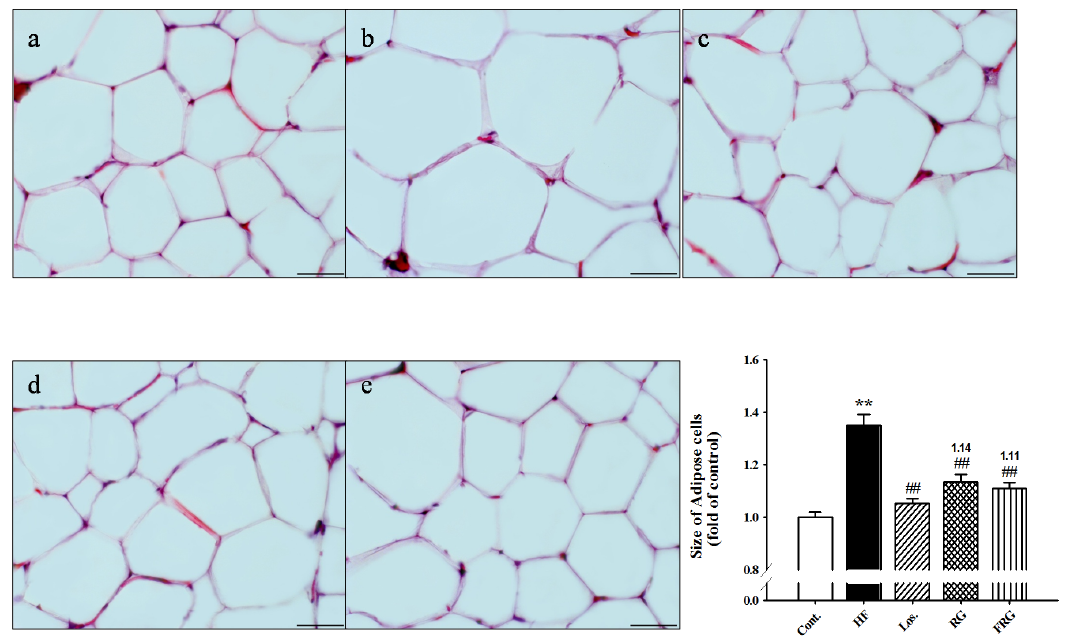
Figure 1. Effects of fermented red ginseng (FRG) on adipocytes on high fructose (HF) diet rats. Representative microscopic photographs of hematoxylin and eosin (H & E) stained sections of epididymal fat pads in HF diet rats. The lower panels indicated the size of adipose cells (magnification ×400). Scale bar shows 50 μ m. ( a ) control; ( b ) HF; ( c ) HF + Losartan (Los.); ( d ) HF + RG (red ginseng); ( e ) HF + FRG (fermented red ginseng). Values were expressed as mean ± S.E. ( n = 3). ** p < 0.01 versus Cont.; ## p < 0.01 versus HF. Table 2. Effect of FRG on plasma